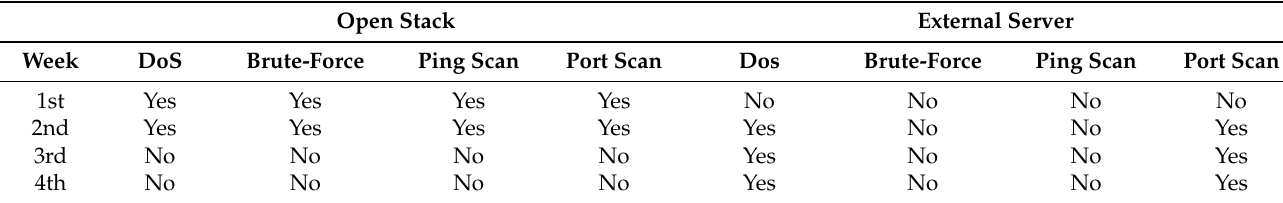
Table 2. Attack distribution over